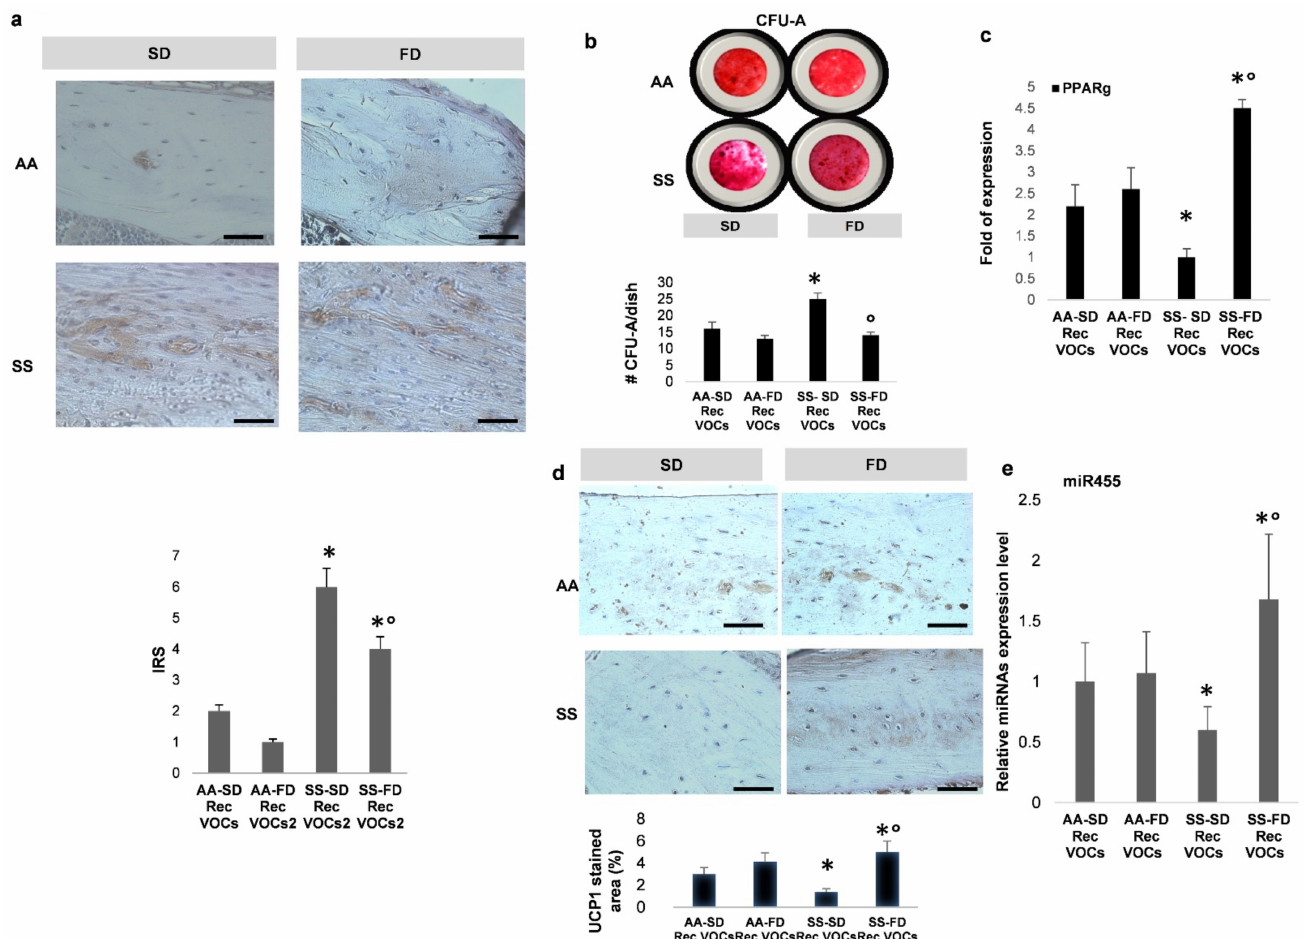
Figure 4. In SCD mice, FD reduces and re-programs adipogenesis from white to brown adipocyte tissue. ( a ) Upper panel . Representative images from bone sections of SD/FD AA and SD/FD SS mice exposed to recurrent H/R (rec H/R) stained for Perilipin, a lipid droplet-membrane component. Scale bar: 50 uM. Lower panel . IRS expresses the product of Perilipin staining intensity (between negative = 0 and strong = 3) and the percentage of positive Perilipin stained cells. ( b ) To assess the number of adipocytic progenitors, bone marrow derived cells were cultured in vitro under adipogenic (A) differentiation condition. The CFU-A obtained from mesenchymal stem cells of AA and SS mouse groups were stained with Oil Red O (ORO) ( upper panel ) and quantified ( lower panel ). By comparing the number of CFU-A (colony forming unit-adipogenic), we observed a decreased number of CFU-A in FD SS fed mice, which is in agreement with the decreased adipocyte commitment of progenitor cells. ( c ) Real-time PCR analysis of peroxisome proliferator-activated receptor2- γ (PPAR2g) in SD/FD AA/SS mice exposed to rec H/R. ( d ) Upper panel . Representative images of bone sections of SD/FD AA and SD/FD SS mice exposed to recurrent H/R (rec H/R) stained for Uncoupling protein-1 (UCP1, brown). Scale bar: 50 uM. Lower panel . UCP-1 quantification. ( e ) miR455 expression in bone from SD/FD AA and SD/FD SS mice exposed to recurrent H/R (rec H/R). ( a , b , d , e ) Data are shown as mean ± standard deviation (SD); at least six independent experiments have been performed; * p < 0.05 compared to AA; ◦ p < 0.05 compared to SD ( c , e ) Data are shown as mean ± standard deviation (SD) ( n = 4; 2 females and 2 males). * p < 0.05 compared to AA; ◦ p < 0.05 compared to